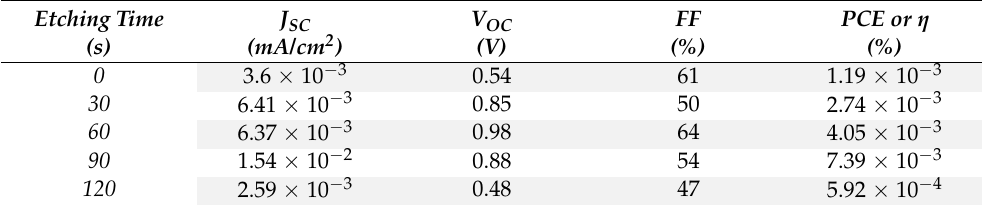
Table 1. Performance of Al/p-c-Si/PSi/Ag photovoltaic cell at different etching